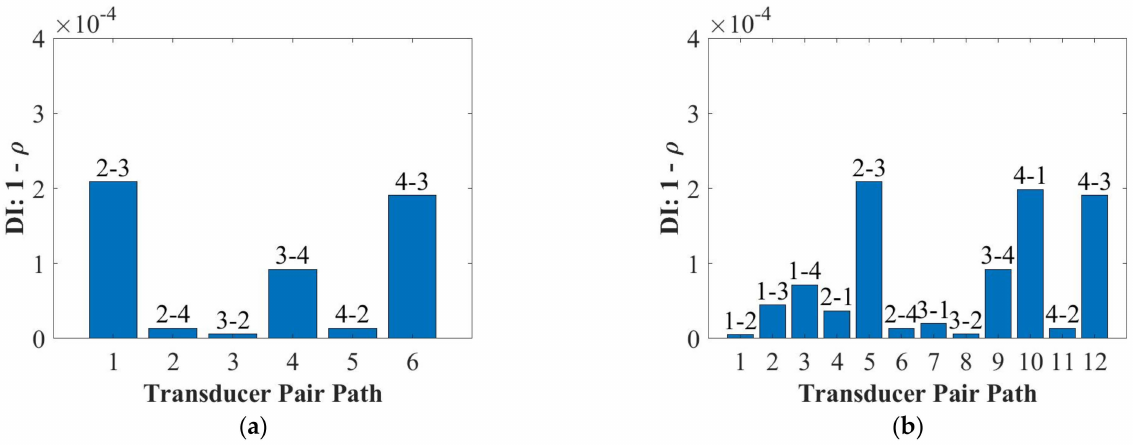
” is the position for (cid:35)